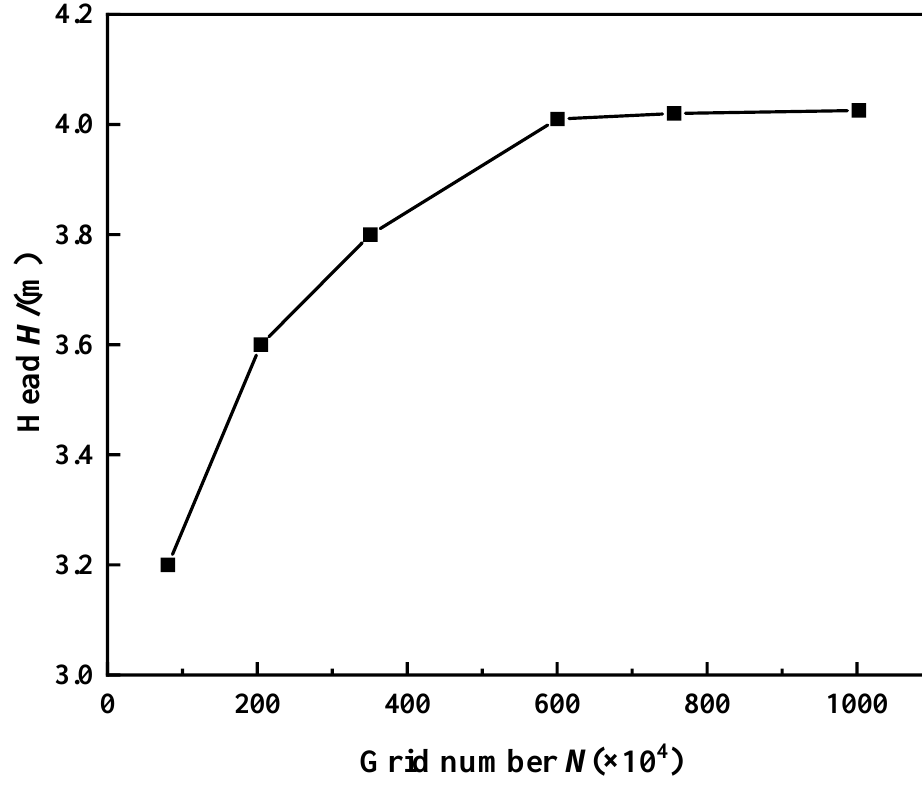
Figure 4. Schematic diagram of grid division of the pump device: ( a ) inlet channel; ( b ) outlet chan- nel; ( c ) guide vane; ( d ) impeller.